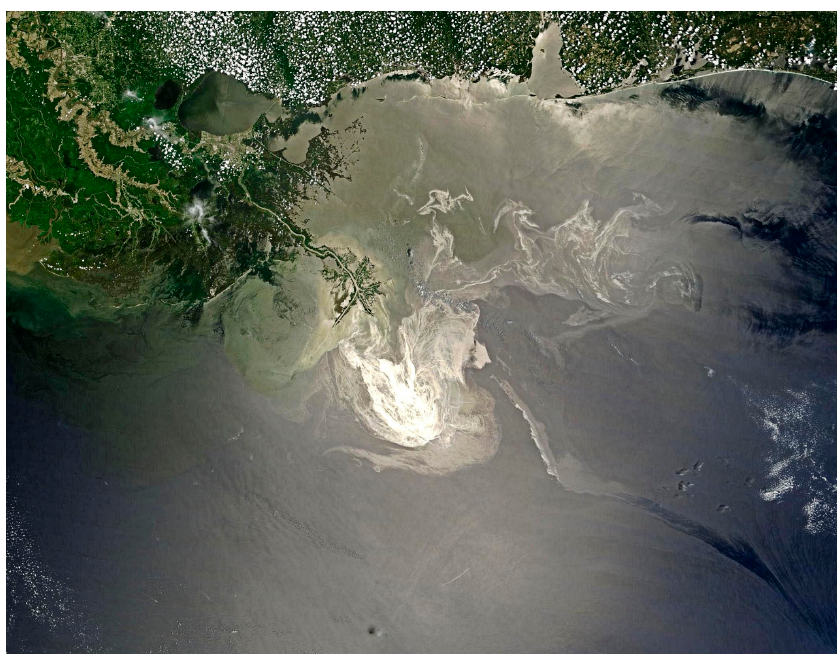
Figure 2. A visible image of the DWH spill. The image is from the NASA Terra satellite and was taken on 24 May 2010. Clouds do not obscure the main part of this image but are present around the periphery (photo from https://en.wikipedia.org/wiki/File:Deepwater_Horizon_oil_spill).